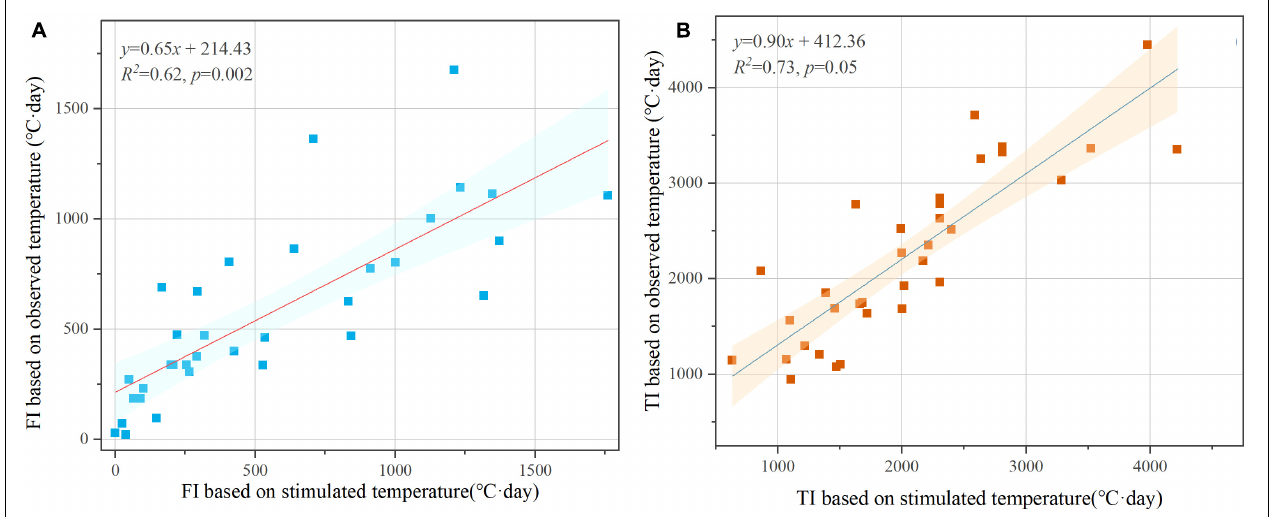
FIGURE 6 | (A) The linear approximation between the mean annual FI based on the observed temperature and the mean annual FI based on the stimulated temperature. (B) The linear approximation between the mean annual TI based on the observed temperature and the mean annual TI based on the stimulated temperature of the 34 meteorological stations sites during